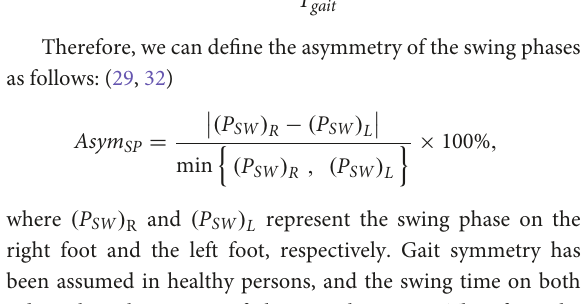
from the TO to the next HS and takes about 40% of the gait cycle. Because gaits are periodic, a single gait cycle can be